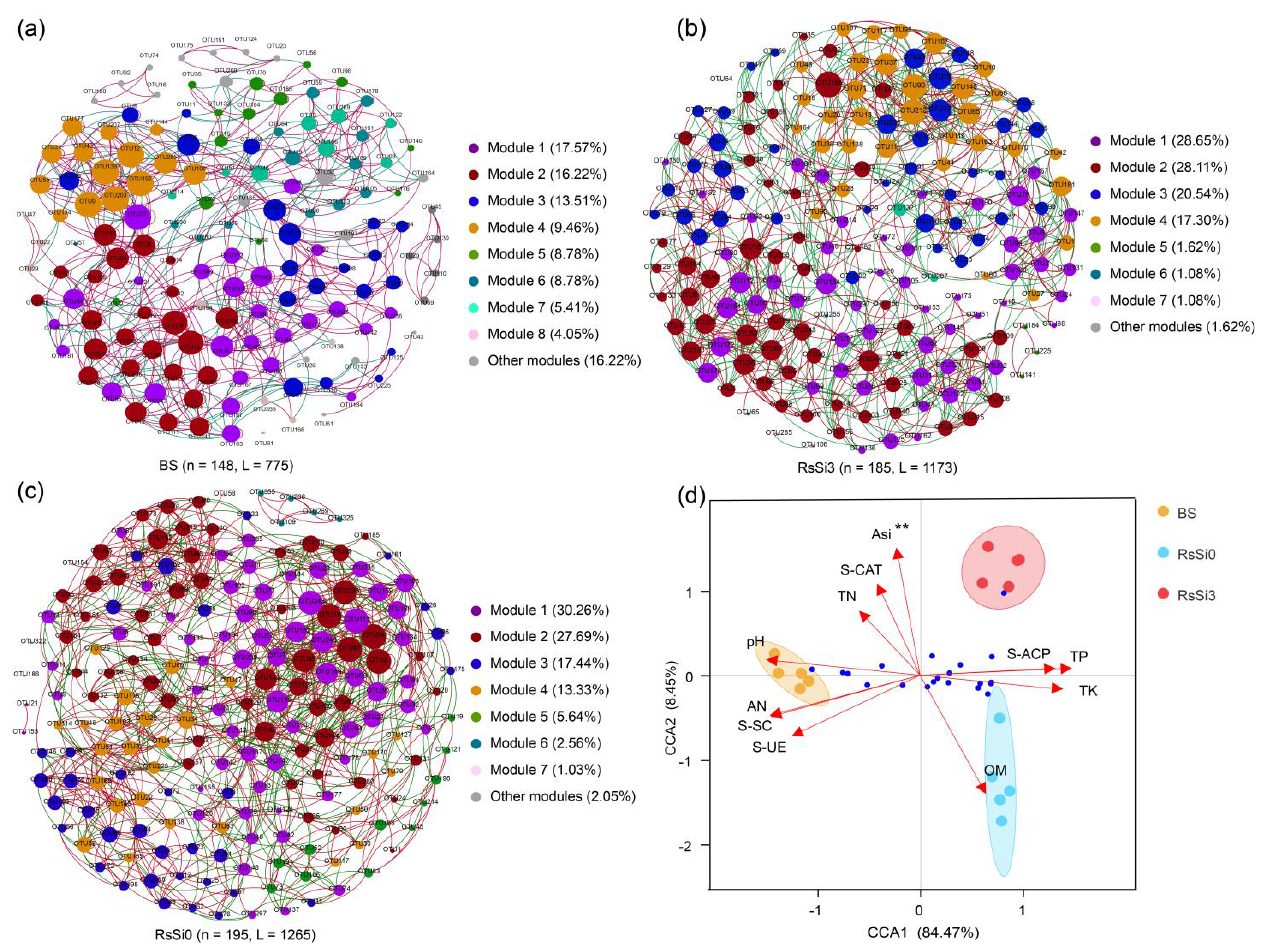
Figure 4. Impact of Si on the structures of the rhizosphere soil bacterial community under R. solanacearum inoculation. ( a – c ) Co − occurrence network module analysis of OTUs (relative abundance > 0.1%) under BS, RS, and RSSI treatments, respectively. Nodes were colored according to modularity type, and the connection of lines represents a strong correlation between bacterial OTUs (Spear- man’s r > 0.8 and p < 0.05). A red edge indicates a positive interaction between two individual nodes, while a green edge indicates a negative interaction. ( d ) Canonical correspondence analysis (CCA) based on the bacterial community compositions at the genus level of BS, RS, and RSSI treatments samples. ** Significant at the 0.01 probability level.